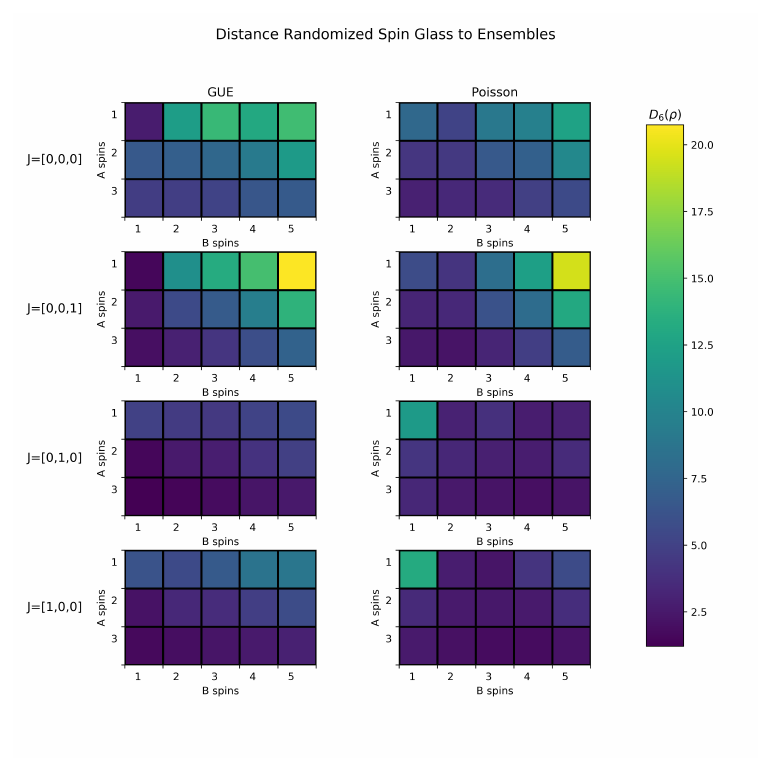
Figure 27: Left: Normalized distance of dynamics of Spin Glass Model (see equation 47) to analytical GUE. Right: to analytical Poisson.